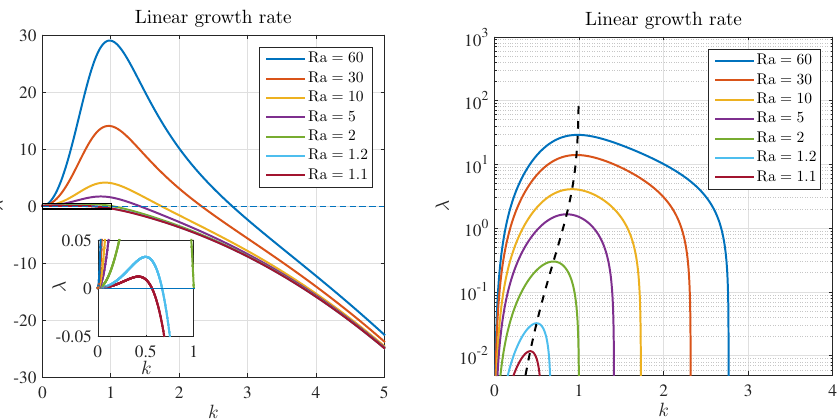
Figure 2. Linear growth rates λ ( k ,0 ) of the elevator modes in the inertia-free salt convection (IFSC) model (20) for different values of Ra in a linear-linear plot (left) and a linear-log plot (right). The inset in the left panel zooms in on the rectangular region where Ra is close to one; the black dashed line in the right panel indicates the fastest growing optimal